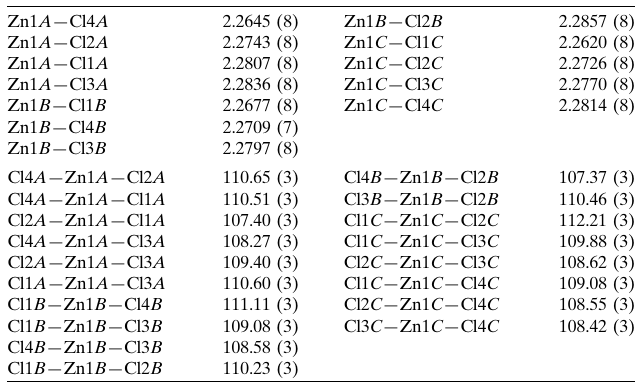
Selected geometric parameters (A˚ , (cid:4)